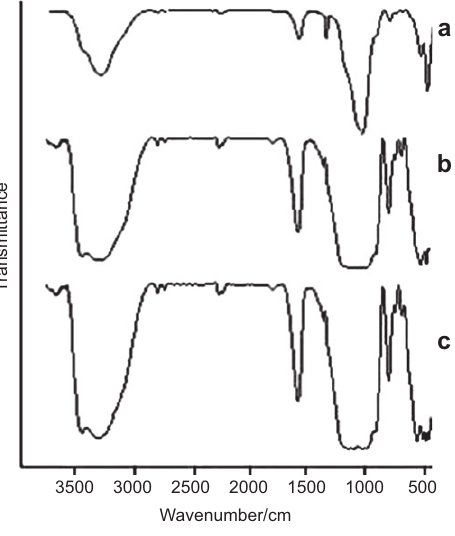
Figure 1 FT-IR spectra of MMT, Ag-MMT-N, and